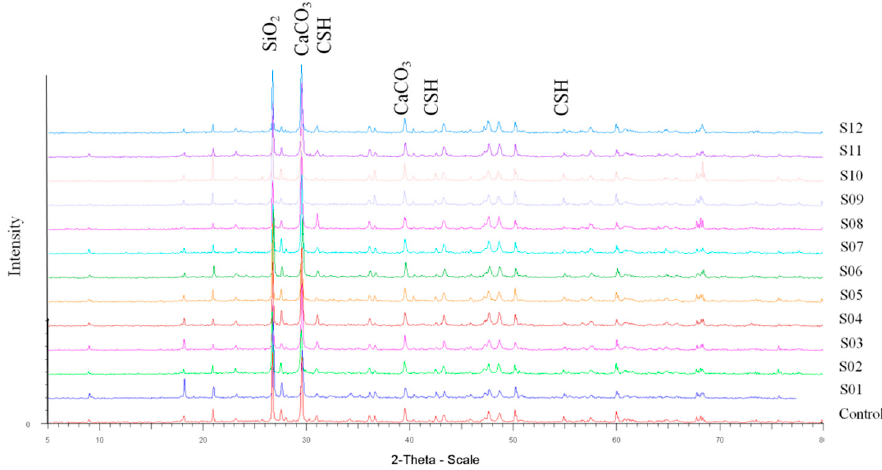
Figure 8. The X-ray di ff raction patterns of concrete bricks. CSH: calcium silicate